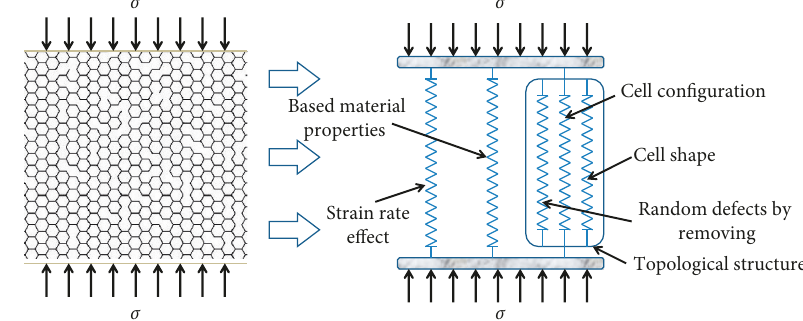
Figure 8: Schematic of simplified constitutive model.